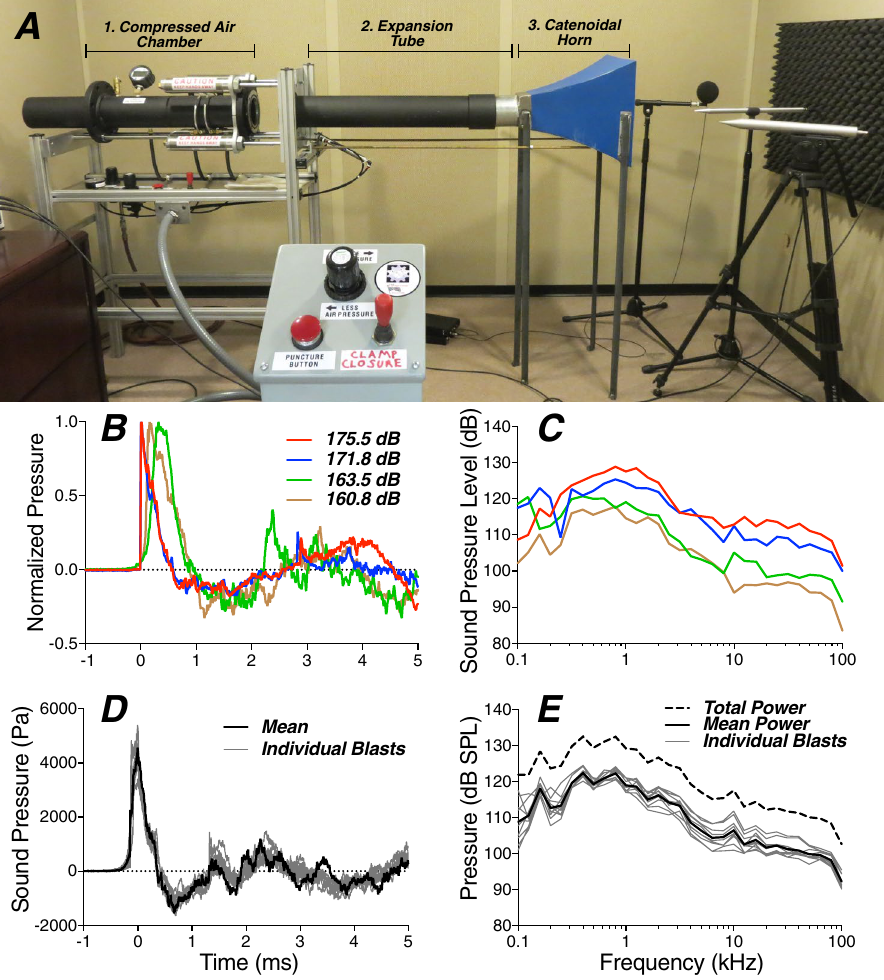
Figure 1. Structure and performance of the custom shock tube. ( A ) Our shock tube consists of a compressed air chamber (1), separated from an expansion tube (2), and catenoidal horn (3) by a thin Mylar or brass membrane (not shown) with a remotely actuated puncture pin. In the image, the air chamber has been pulled away from the expansion tube, and no membrane is in place. The total length of the apparatus, including the horn is 6 ′ 6 ″ . When the air chamber is filled to 27 psi, peak pressures near 175 dB SPL can be reliably produced at the orifice of the horn. ( B ) Example pressure waveforms measured above the animal’s head (at the midline) for levels spanning the range tested and arbitrarily aligned by placing time 0 at 5% peak pressure. ( C ) Example spectra obtained from pressure waveforms, as measured at the tragus, from blasts spanning the range of peak pressures. ( D,E ) Pressure waveforms (peak-aligned) and resultant spectra measured near the tragus during 10 consecutive blasts @ 165 dB SPL